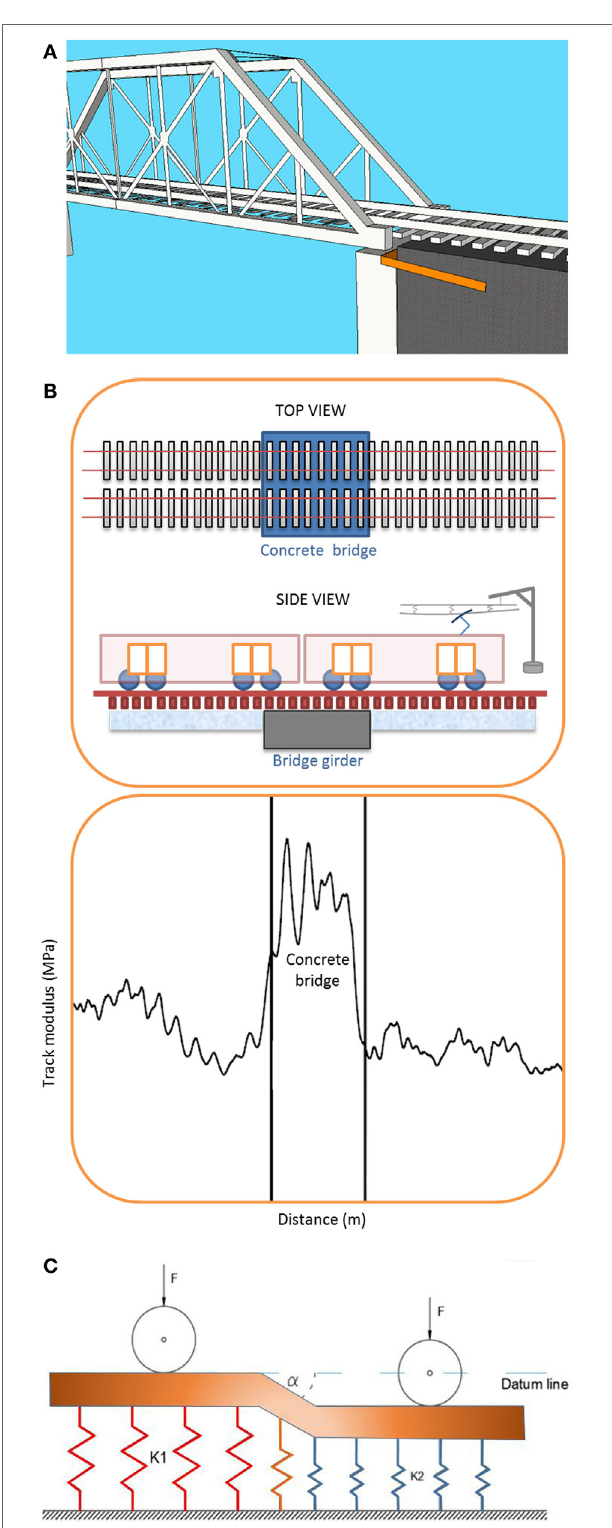
Figure 1 | Track modulus and its interaction with railway system. (a) bridge end area; (B) change in track modulus; (c) change in track stiffness at transition areas ( k 1 is bridge stiffness; k 2 is track stiffness; alpha is the relative dip angle).